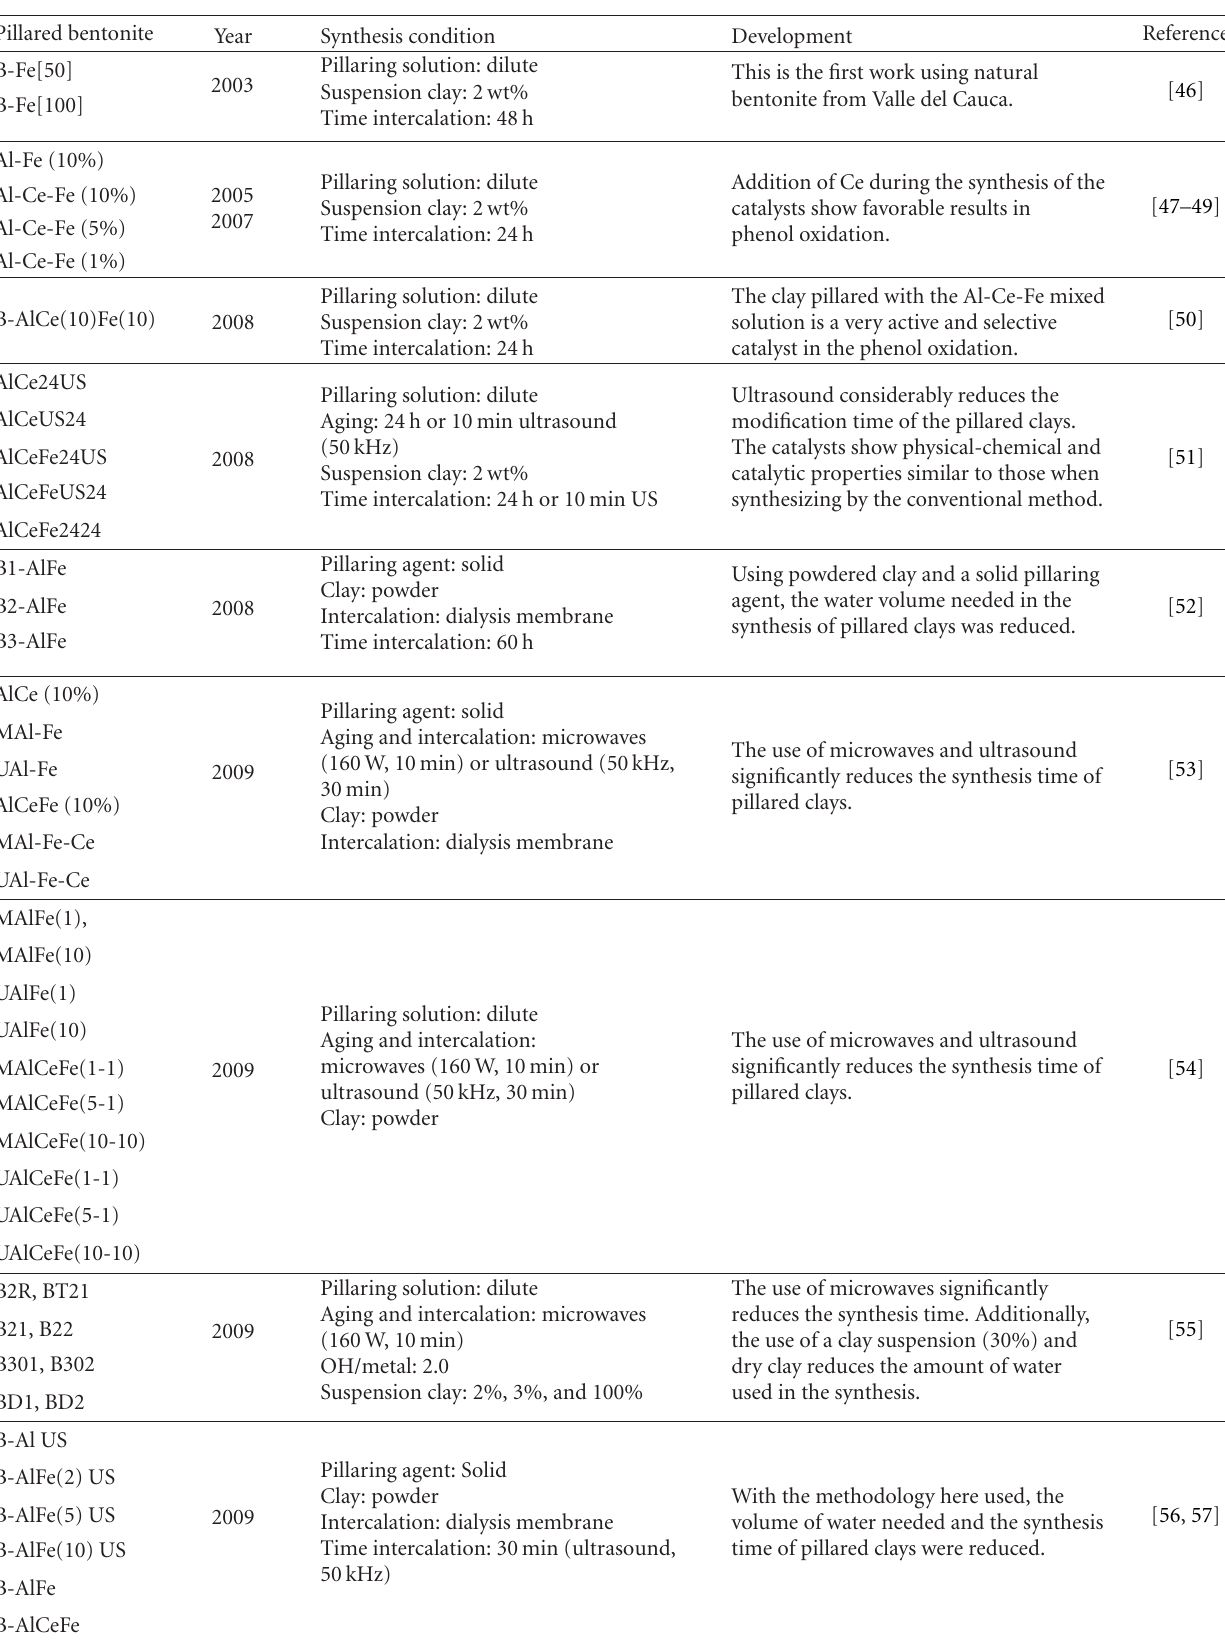
Table 1: Bentonite-based catalysts for oxidation of phenol using Fenton-like